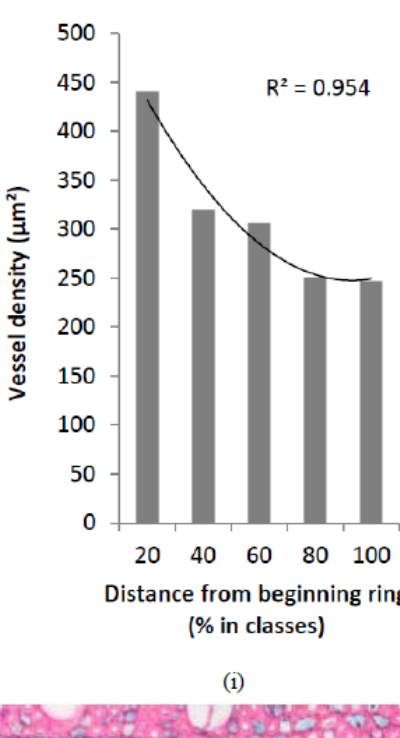
Figure 4. Microphotograph of the wound tissue formed in response to the cambial pinning. The cambial mark is indicated with black arrows in ( A ) sample Tw64884 and ( B ) sample Tw64881. The trees were marked on March 15 2012 and sampled after 498 days on July 25 2013. The tree-ring boundaries are indicated with white arrows.